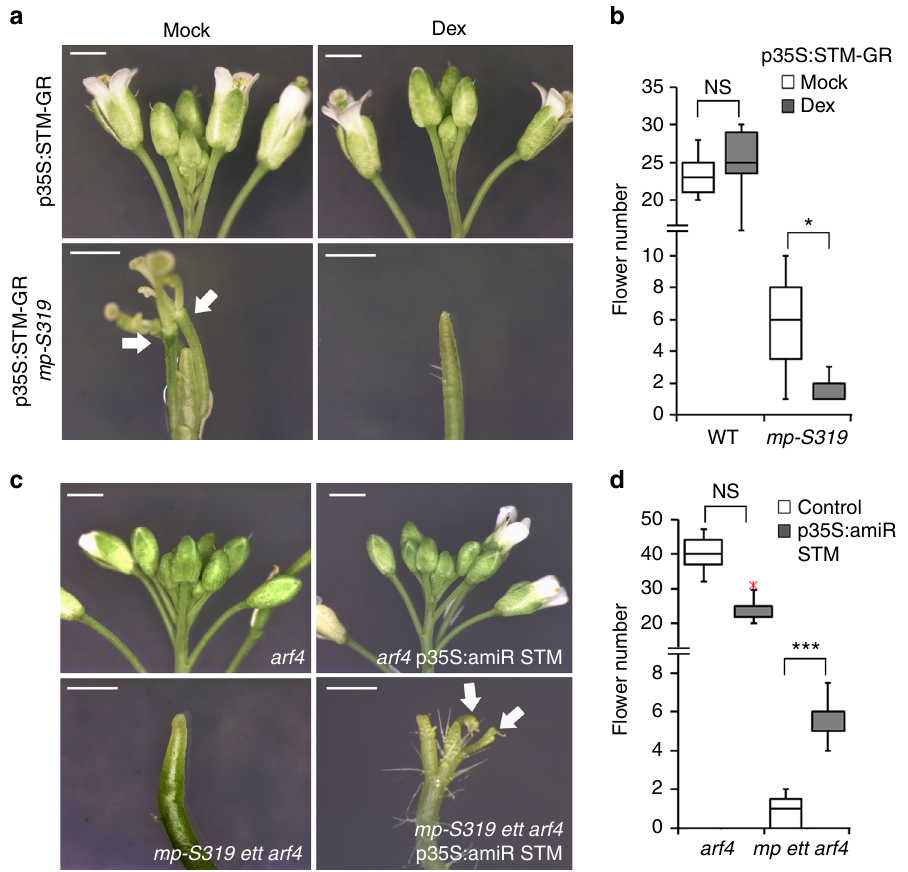
Fig. 3 STM downregulation is important for fl ower initiation. a , b Primordium initiation defect of mp-S319 compared to mp-S319 without (Mock) and with conditional increase in STM activity upon activation of p35S:STM-GR with the synthetic steroid dexamethasone (Dex). a Phenotype; white arrow points to developing fl owers. Scale bar = 1 mm. b Quanti fi cation of fl owers initiated. Box and whisker plot: Lower vertical bar = sample minimum. Lower box = lower quartile. Black Line = median. Upper box = upper quartile. Upper vertical bar = sample maximum. NS P -value = 0.11, * P -value = 0.024 one-tailed Mann – Whitney U test. n = 15 and 11 (WT mock and dex) n = 8 and 5 ( mp-S319 mock and dex). Source data are provided as a Source Data fi le. c , d Primordium initiation defect of mp-S319 ett arf4 compared to mp-S319 ett arf4 plants in which STM expression is knocked down using an arti fi cial microRNA, amiRSTM 35 . c Phenotype; white arrow points to developing fl owers. Scale bar = 1 mm. d Quanti fi cation of fl owers initiated. Box and whisker plot: Lower vertical bar = sample minimum. Lower box = lower quartile. Black Line = median. Upper box = upper quartile. Upper vertical bar = sample maximum. NS P -value = 0.99; *** P -value = 0.00001 one-tailed Mann – Whitney U test. n = 11( arf4 ), n = 13 ( arf4 p35S:amiRSTM ), n = 8 ( mp-S319 ett arf4 ), n = 15 ( mp-S319 ett arf4 p35S:amiRSTM ). arf4 is indistinguishable from the wild type 20 . Source data are provided as a Source Data fi